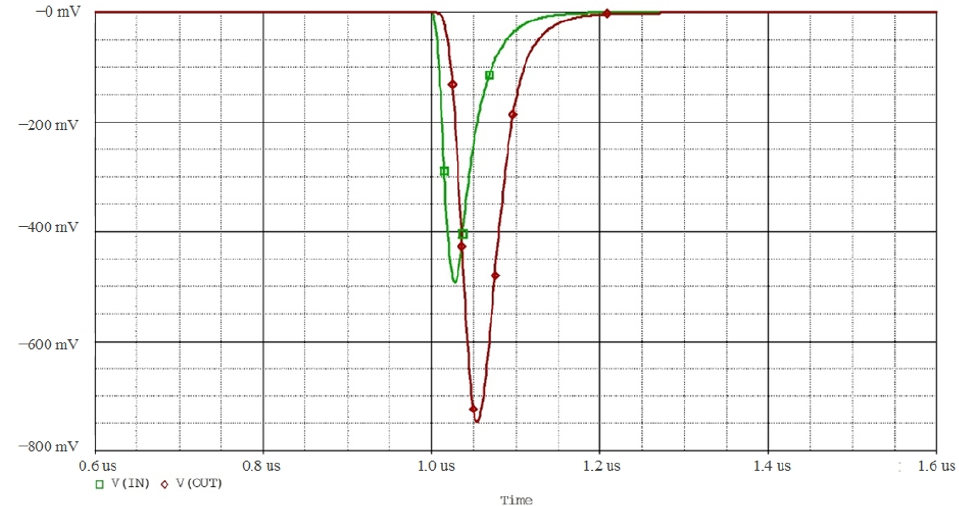
Figure 8. The simulation of the airborne prototype ACB at magnification of 2.